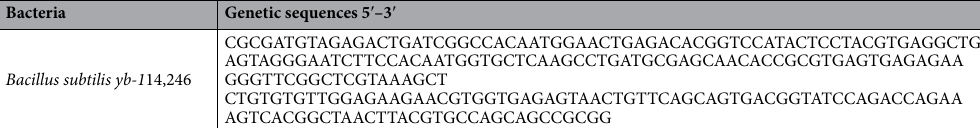
Table 3. The probes Bacillus subtilis yb-1 14,246.